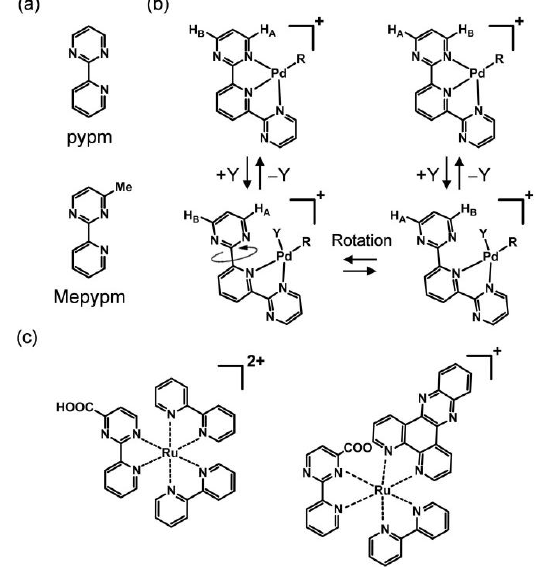
Figure 1. ( a ) Structure of 2-(2'-pyridyl)pyrimidine (pypm). ( b ) Ring rotation of a metal complex bearing a pypm-type ligand. ( c ) Two possible isomers of a Ru complex possessing a substituted pypm ligand. Geometric isomers are omitted for